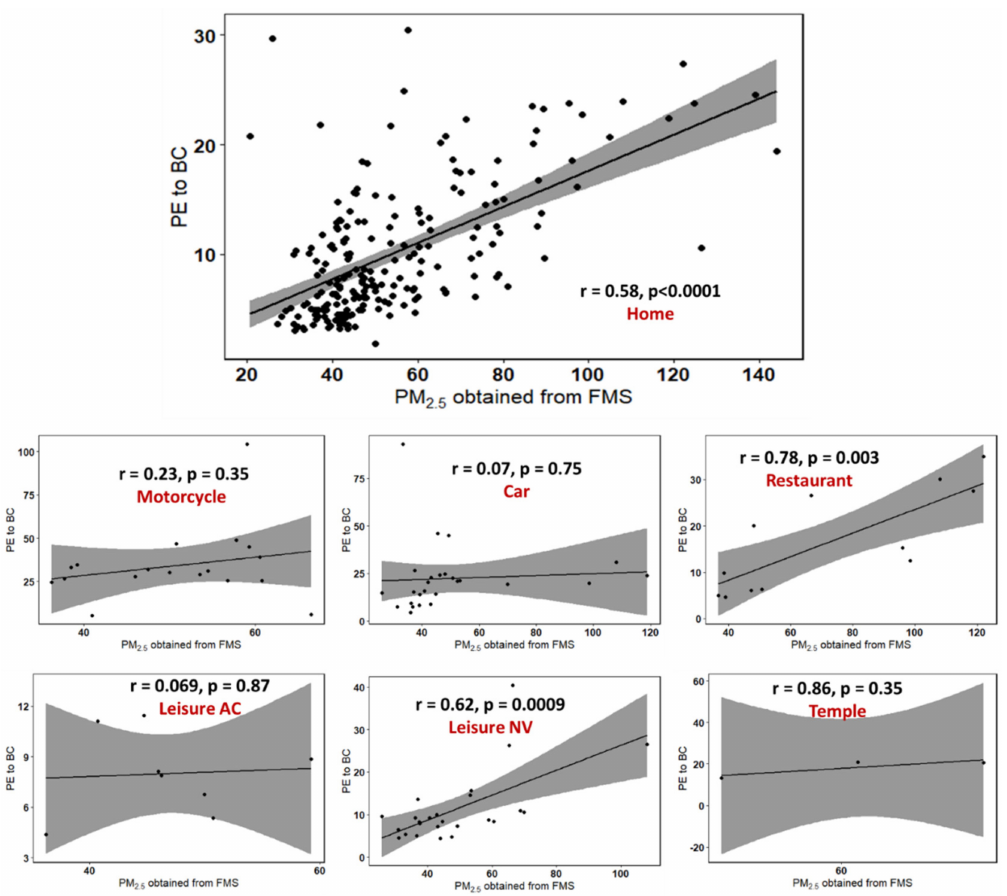
Figure A3. Correlation between PE to BC and PM 2.5 concentrations obtained from FMS across different MEs for the two participants. The shaded grey area is representative of the 95% confidence